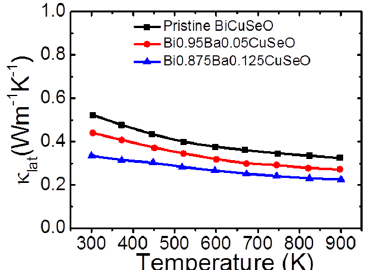
Figure 9. The lattice thermal conductivity of Bi 1 − x Ba x CuSeO ( x = 0, 0.05, 0.125). Reproduced with permission from Reference [65]. Copyright 2016, Elsevier Science.